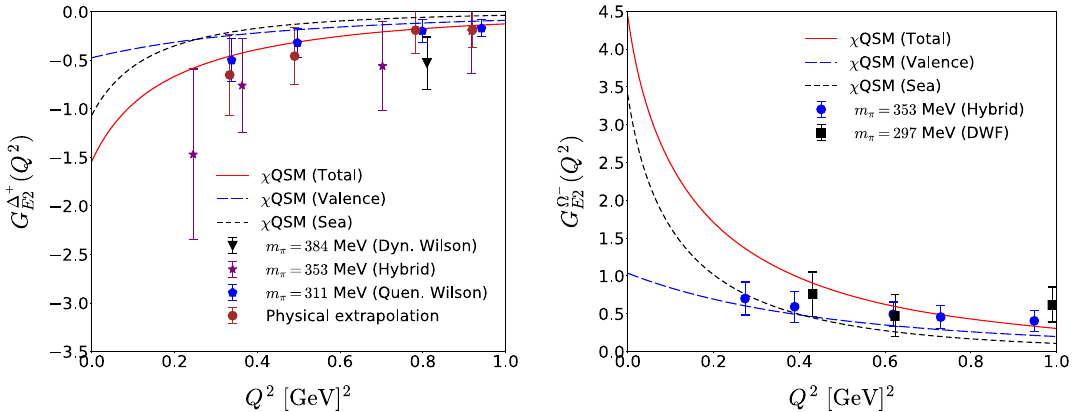
Fig. 5 Contributions of the valence and sea quarks to the electric quadrupole form factors of the (cid:2) + isobar and (cid:5) − in the left and right panels, respectively. Notations are the same as in Fig. 1. The lattice data are taken from Refs.